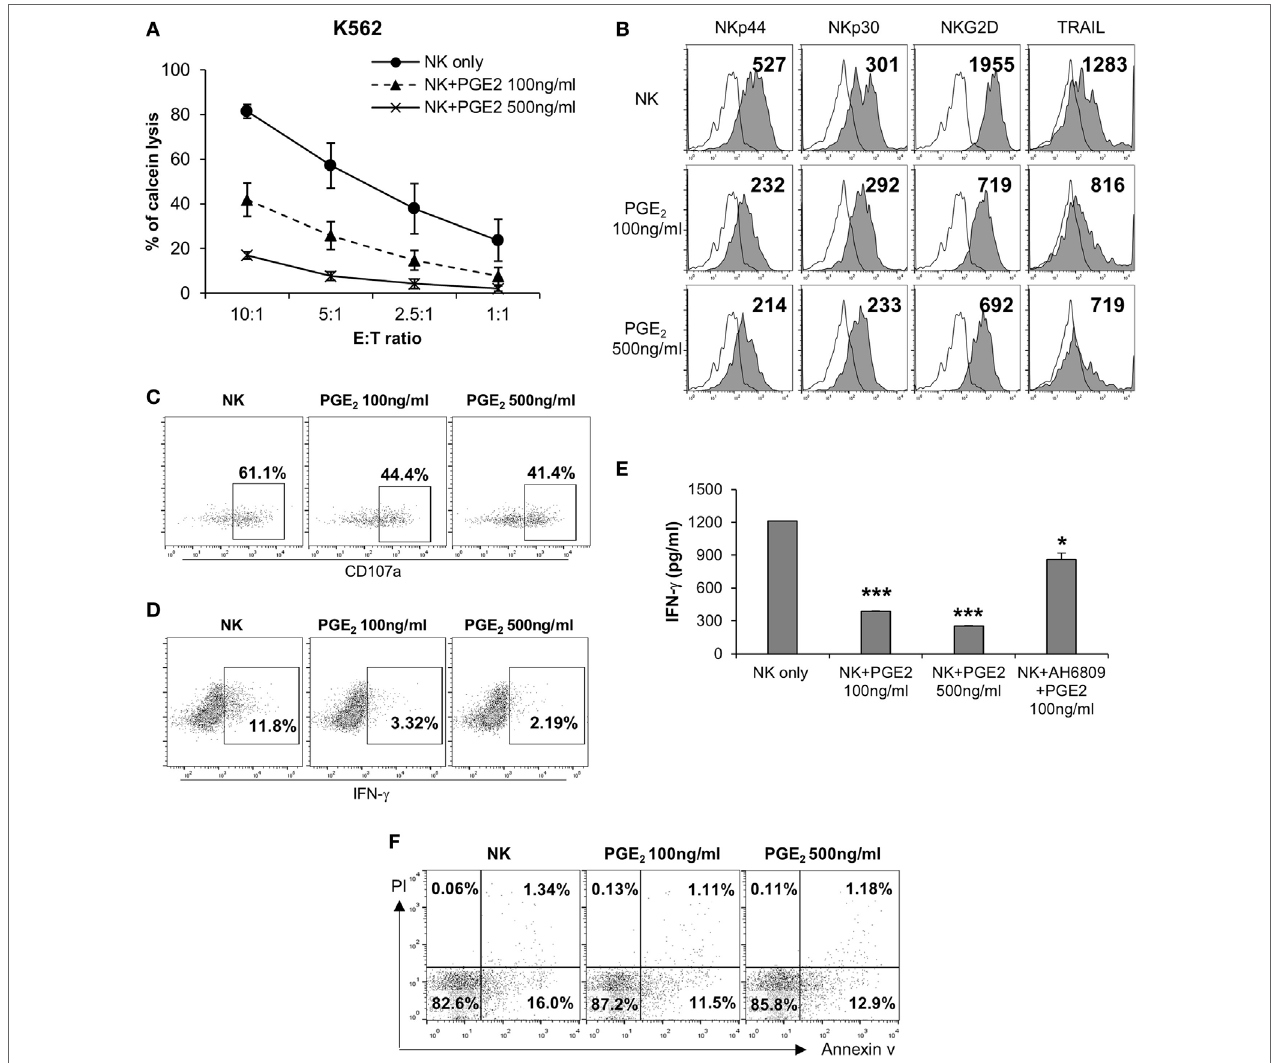
FigUre 4 | PGE2 inhibits natural killer (NK) cell activity and receptor expression. (a) NK cells were cultured with IL-2 (circle) in the absence or presence of 100 ng/ml (triangle) or 500 ng/ml (cross) PGE2 for 24 h and cytotoxicity was against K562 cells was examined. Bars represent mean ± SD of three independent experiments. (B) Expression of NK receptors, including NKp44, NKp30, NKG2D, and TRAIL (filled profiles) and isotype controls (white profiles), as detected by flow cytometry. Numbers indicate mean fluorescence intensity. Y -axis shows cell counts. (c) Expression of CD107a on the surface of NK cells detected by flow cytometry. Numbers indicate percentage of CD107a + expression. (D) IFN- γ level in NK cells analyzed by intracellular staining and flow cytometry. Numbers indicate percentage of positive expression. (e) IFN- γ concentration in culture supernatants of NK cells with or without PGE2 treatment, as determined by enzyme-linked immunosorbent assay. Bars represent mean ± SD of three independent experiments. * P < 0.05 and *** P < 0.001. (F) Apoptosis of NK cells analyzed by annexin V/ propidium iodide staining and flow